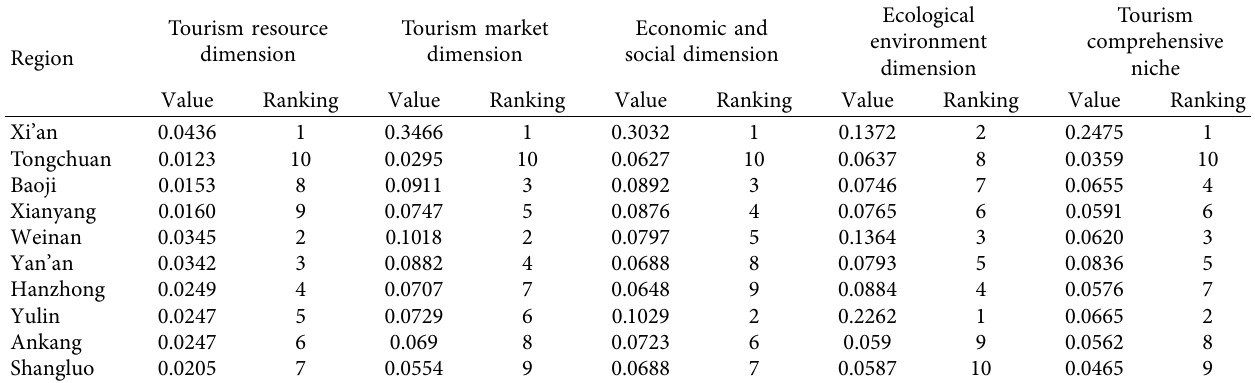
Table 2: Composite niche and ranking of prefectures, 2018.